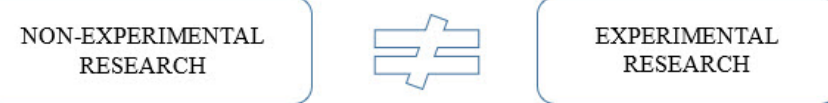
Figure 1. Non-experimental versus experimental